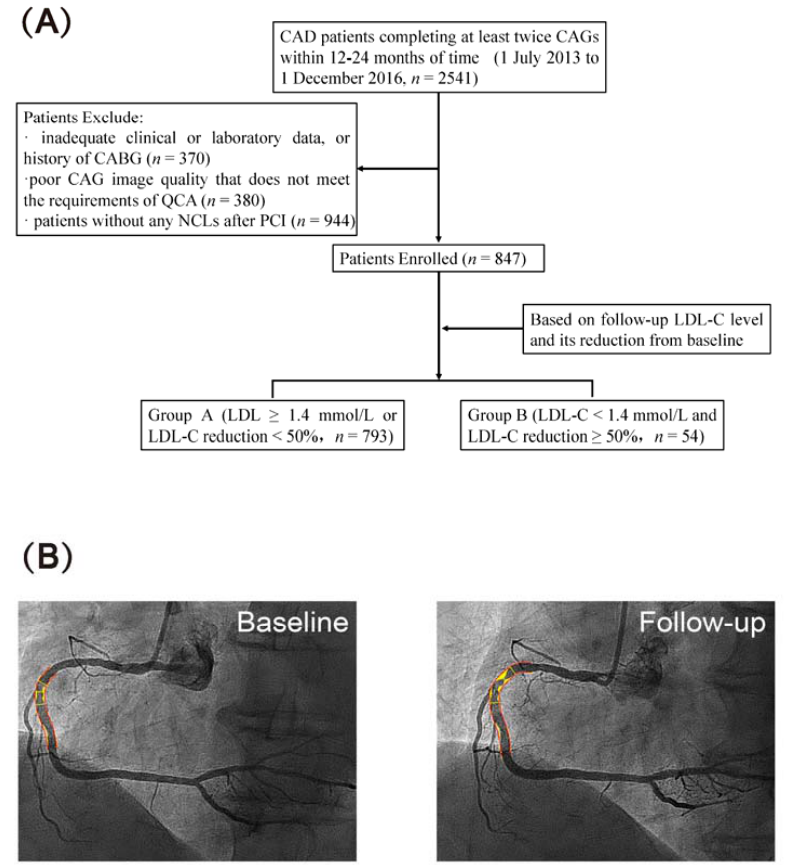
Figure 1. Study population and quantitative coronary angiography. ( A ) Flow chart of patient enrollment. CAG, coronary angiography; CABG, coronary artery bypass graft; QCA, quantitative coronary angiography; NTL, non-target lesion; PCI, percutaneous coronary intervention; LDL-C, low- density lipid-cholesterol. ( B ) A representative QCA result of NTL plaque progression. Angiography of the right coronary artery at Baseline and